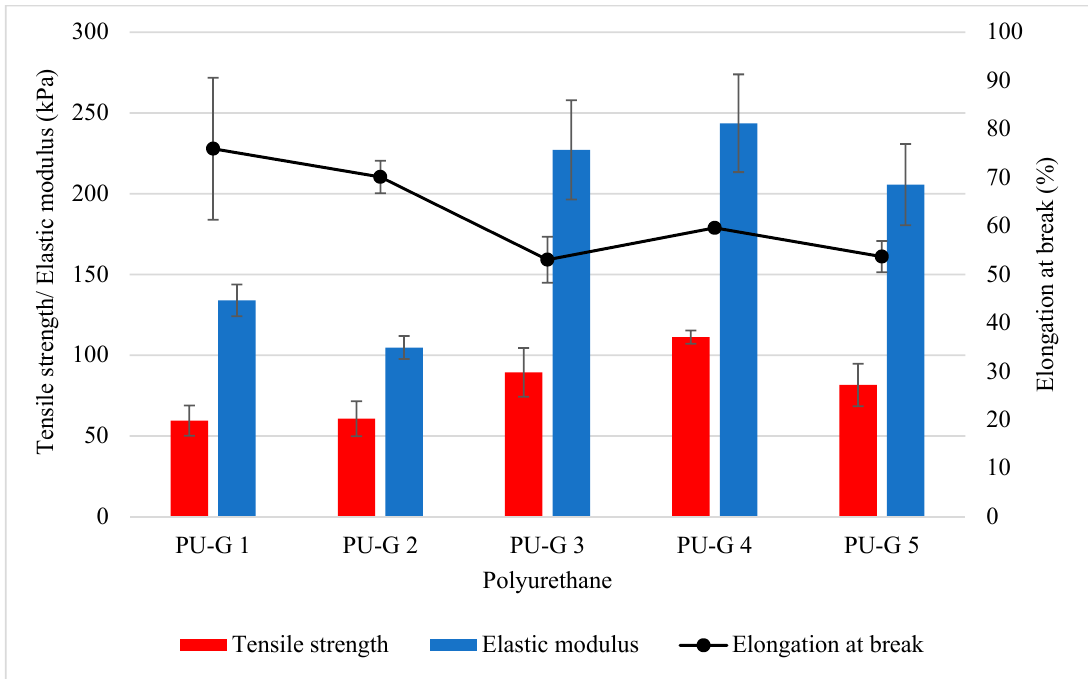
Figure 3. Tensile strength, elastic modulus and elongation at break of polyurethanes produced by different water content of 0.6 g (PU-G 1), 0.8 g (PU-G 2), 1.0 g (PU-G 3), 1.2 g (PU-G 4) and 1.4 g (PU-G 5) (Mean ± SD, n = 3).